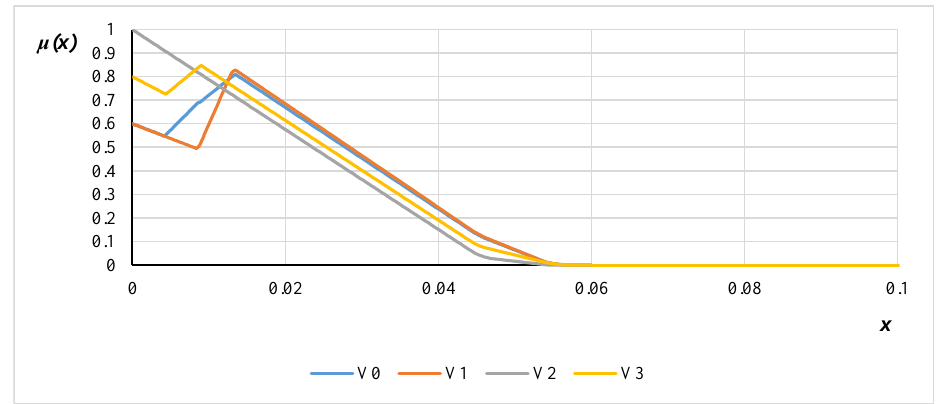
Figure 17. Total susceptibility of c alternatives when analysing negative relationships.